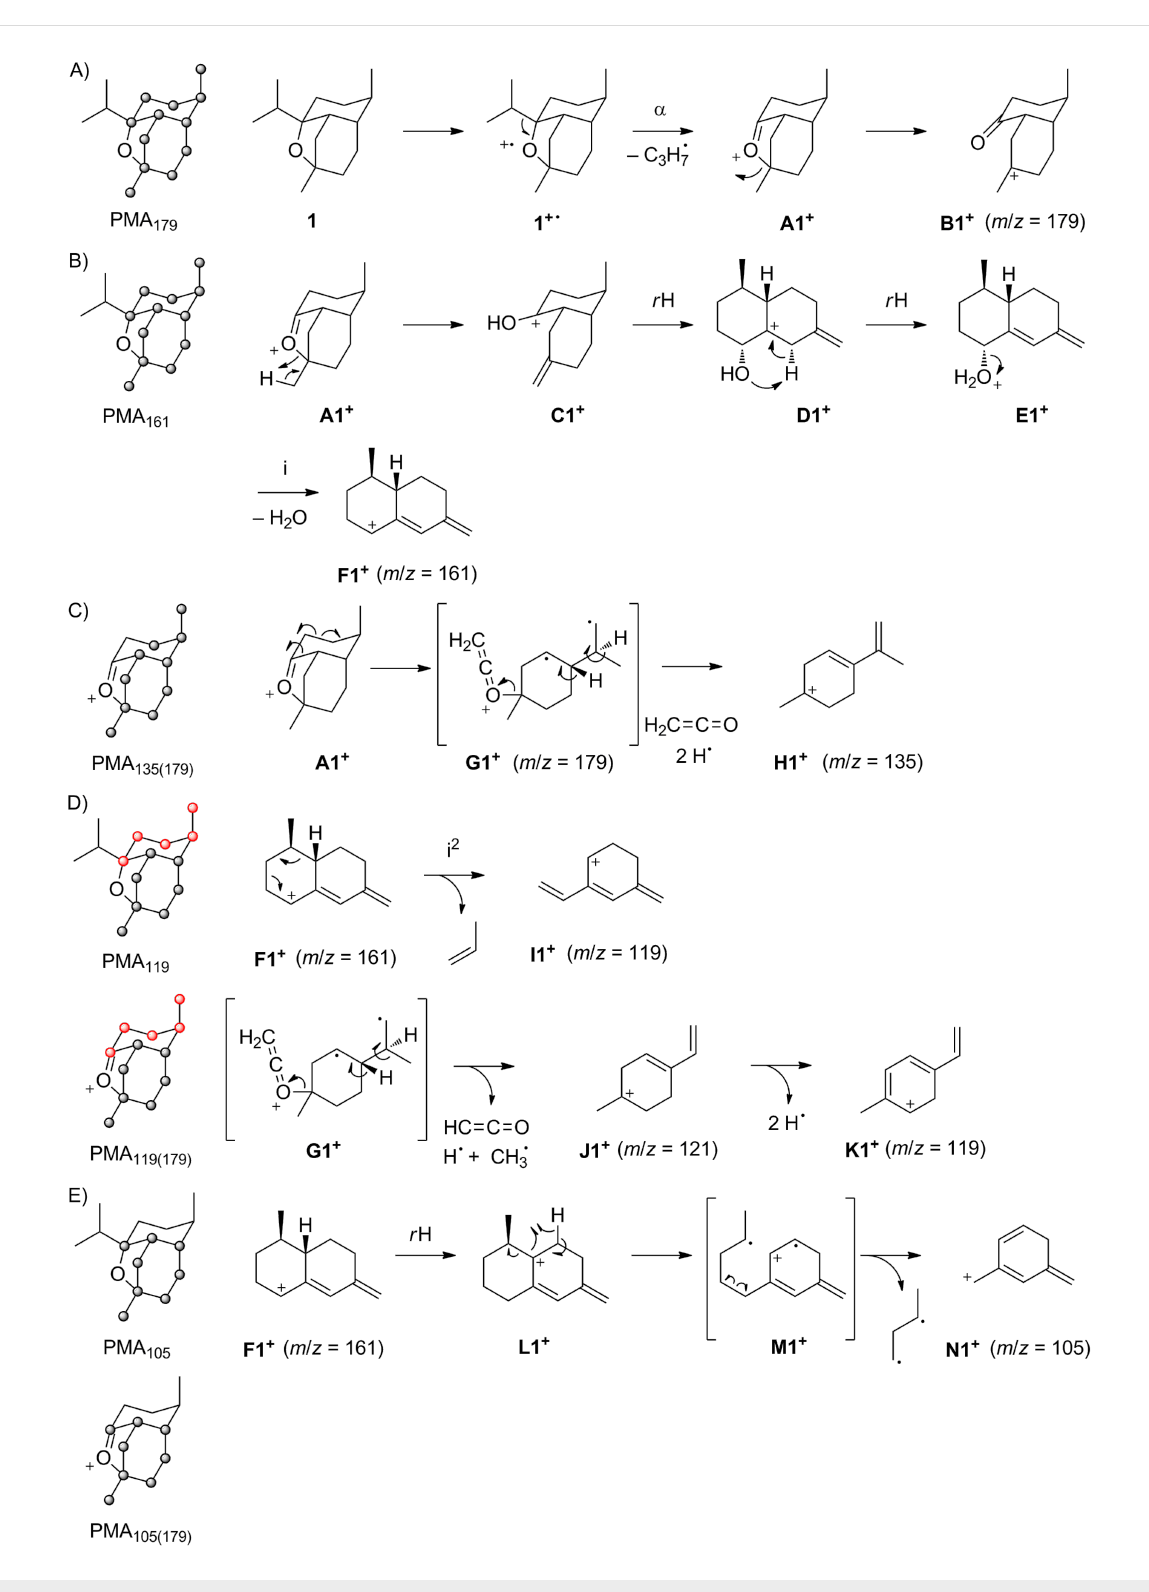
Scheme 2: PMAs and EIMS fragmentation mechanisms for the fragment ions A) m / z = 179, B) m / z = 161, C) m / z = 135, D) m / z = 119 and E) m / z = 105 of 1 . Black carbons contribute fully and red carbons contribute partially to the formation of a fragment ion. α : α -cleavage, r H: hydrogen rearrangement, i: inductive